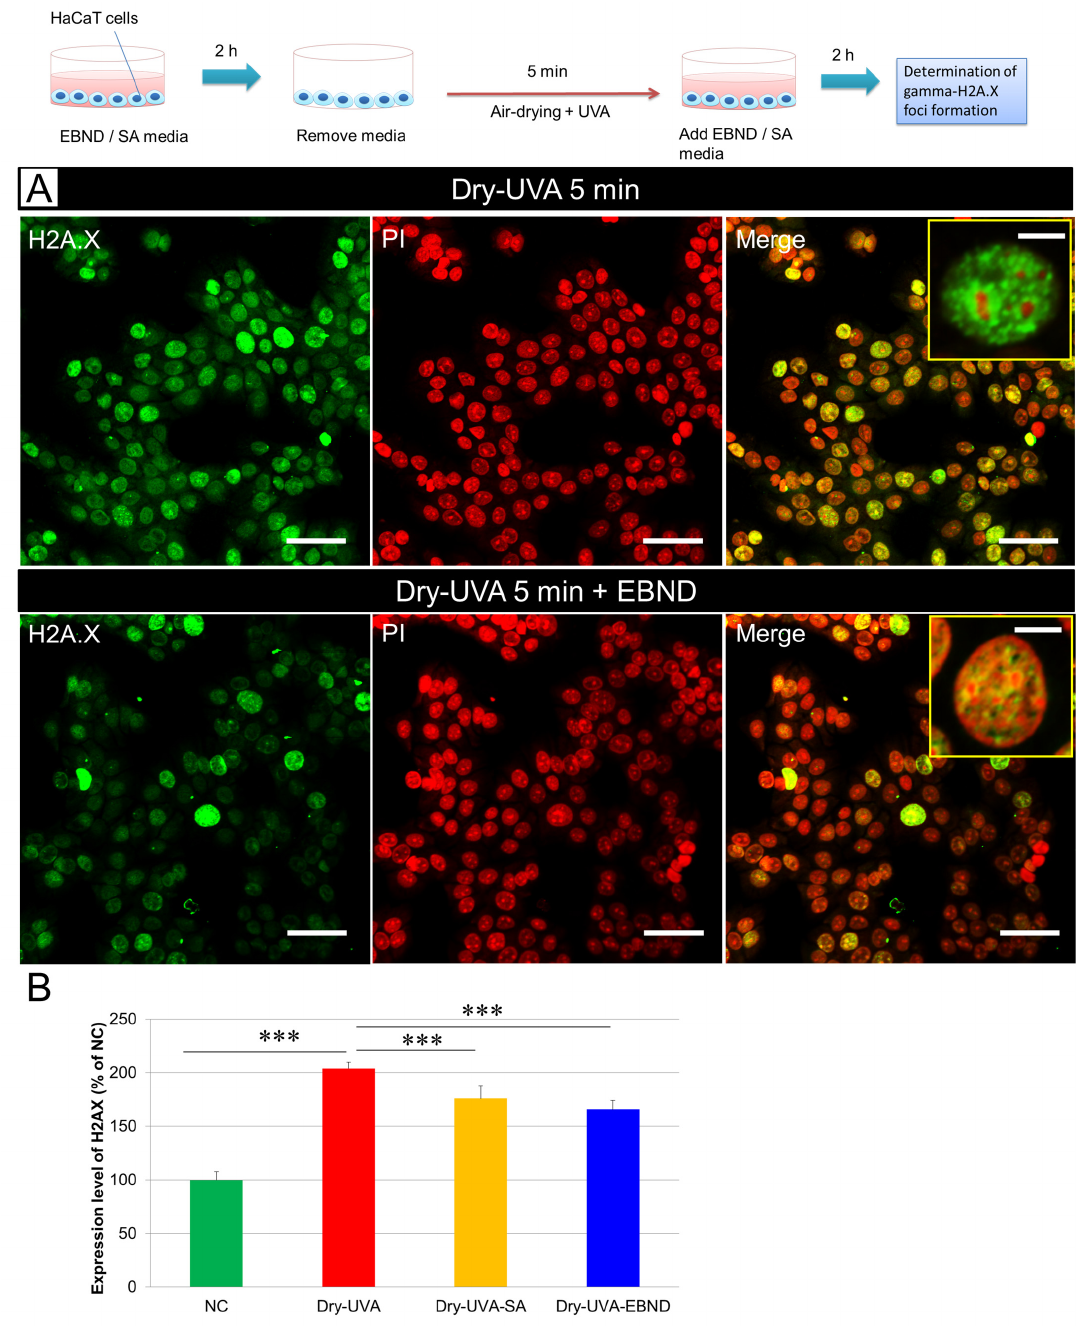
Figure 5. Effect of EBND and SA on Dry-UVA-induced DSBs in HaCaT cells. The top illustration represents the experimental procedures. ( A ) Typical images of anti-H2A.X antibody-based immunofluorescence staining. Green, γ -H2A.X; Red, nuclei (PI). The upper panel shows that 5 min air-drying and UVA irradiation-induced many H2A.X foci formation in HaCaT cells indicating DSBs. The enlarged single-cell image in the upper-right corner displayed many green spots (typical H2A.X foci) in the nucleus. The lower panel shows that with EBND treatment (125 µ g/mL), the expression level of H2A.X was significantly lower. There are fewer green spots in the nucleus of a cell in the enlarged image in the right corner. Scale bars indicate 15 µ m (bigger images) and 5 µ m (smaller images in the upper-right corner; ( B ) Quantitative analysis of the expression level of H2A.X with Tali image-based cytometer as described in “Materials and Methods”. Data represent the mean ± SD of the three independent experiments. *** p <